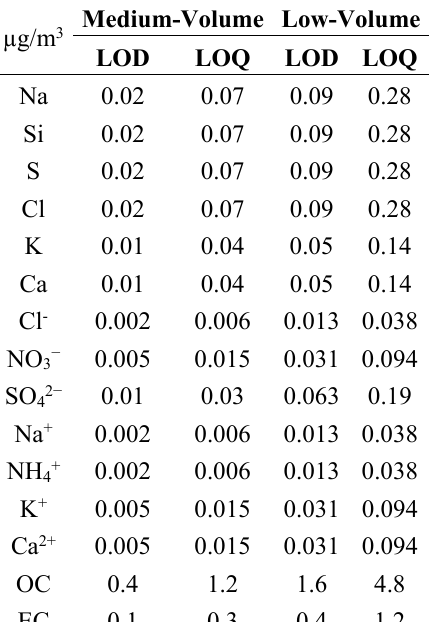
Table A1. Limits of detection (LOD) and limits of quantification (LOQ), expressed in µg/m 3 , of the chemical species analyzed during the study.